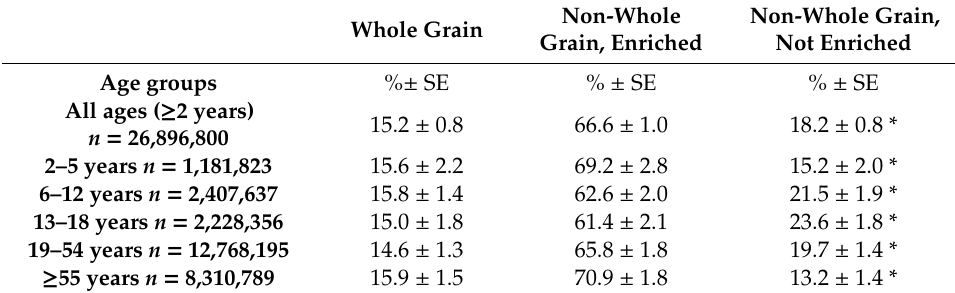
Table 4. Percent contribution of whole grain and non-whole grain (enriched and not enriched) to total grain products at snack occasion 1 . Non-Whole Non-Whole Grain, Whole Grain Grain, Enriched Not Enriched Age groups % ±